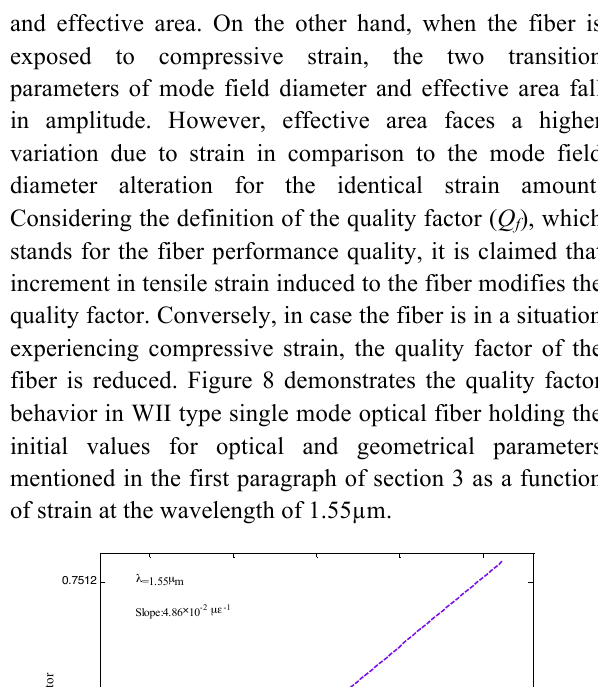
( µ m 2 ) vs. strain for (a) Δ (b) R eff